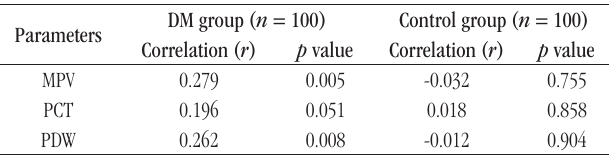
taBLE 5 – Pearson’s correlation and p values for the association between glycated hemoglobin levels and platelet parameters in diabetic patients with chronic complications